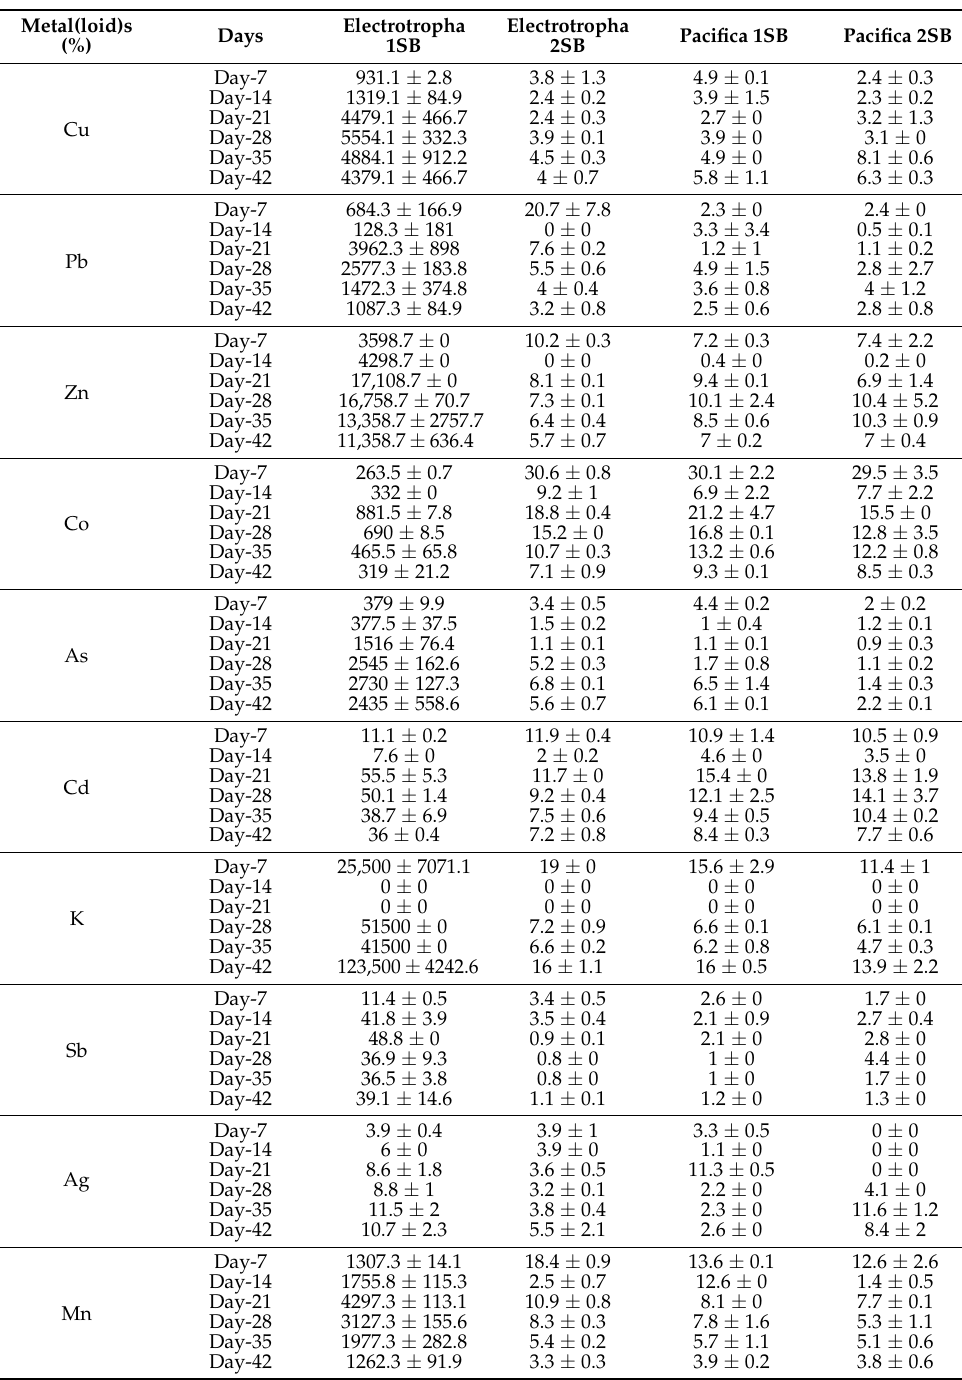
Table A6. Percentages of the metal(loid)s extracted from the Neves Corvo waste rock (NC_01) via one-step bioleaching and two-step bioleaching by T. electrotropha (E-1SB & E-2SB), as well as one-step bioleaching and two-step bioleaching by T. pacifica (P-1SB & P-2SB). Results of weekly serial addition of NC_01 and partial nutrient replacement. Values are the average of duplicate flasks ± standard